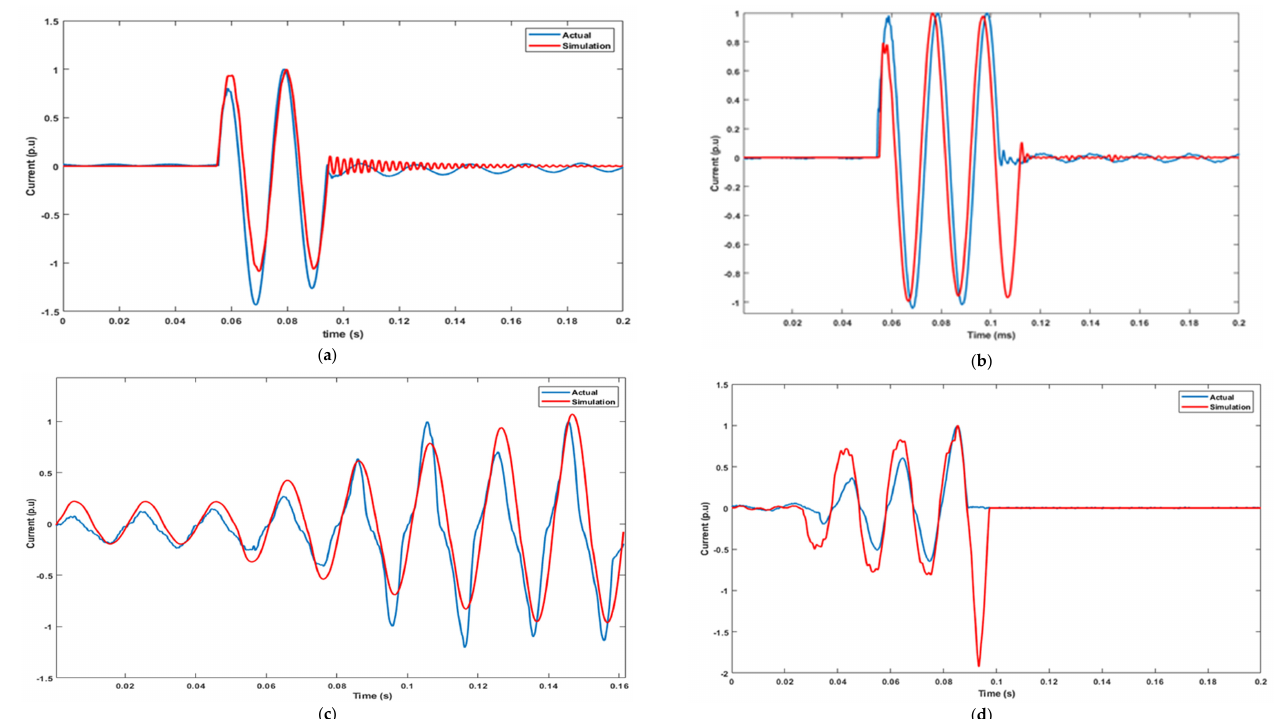
Figure 13. Validation result for generated current waveform due to lightning ( a ), insulator degrading ( b ), tree encroachment ( c ), and crane encroachment ( d ). Appl. Sci. 2021 , 11 , x FOR PEER REVIEW